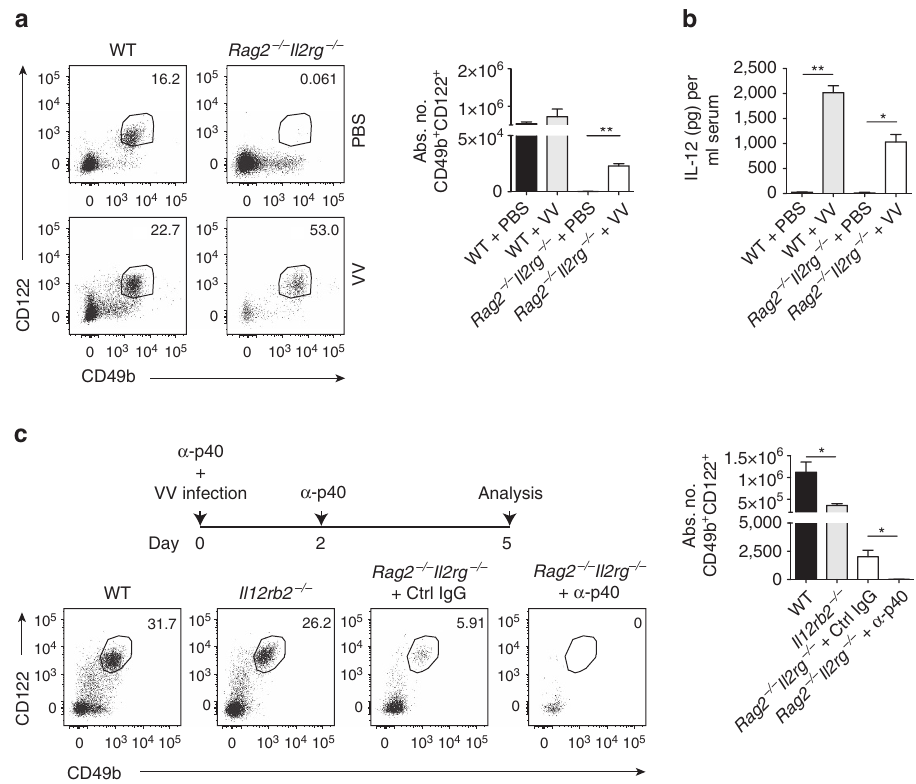
Figure 1 | VV infection generates IL-12-dependent CD122 þ CD49b þ NK cells. ( a ) Representative plots and quantification of lung CD45 þ CD3 (cid:2) CD122 þ CD49b þ cells of uninfected versus VV-infected WTor Rag2 (cid:2) / (cid:2) Il2rg (cid:2) / (cid:2) mice. Data represent two similar experiments ( n ¼ 3–5 mice per group per experiment). ( b ) IL-12 serum levels in VV-infected WT or Rag2 (cid:2) / (cid:2) Il2rg (cid:2) / (cid:2) mice were compared to controls. Data represent two